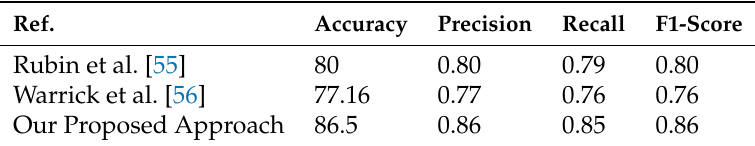
Table 11. Comparison with state-of-the-art